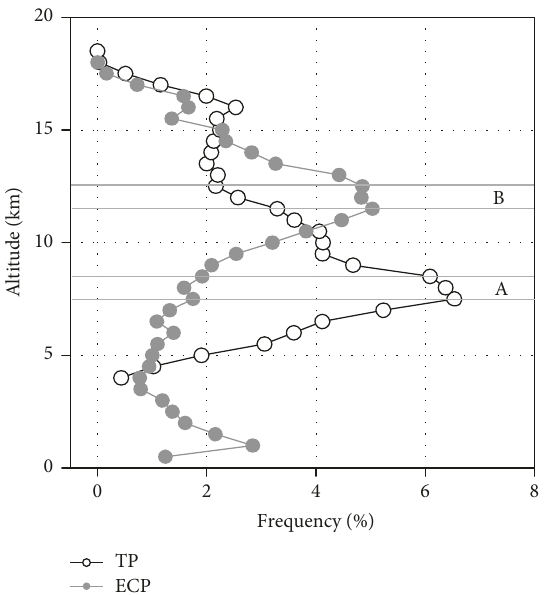
Figure 3: The regionally averaged occurrence of CTH over the TP and the ECP.